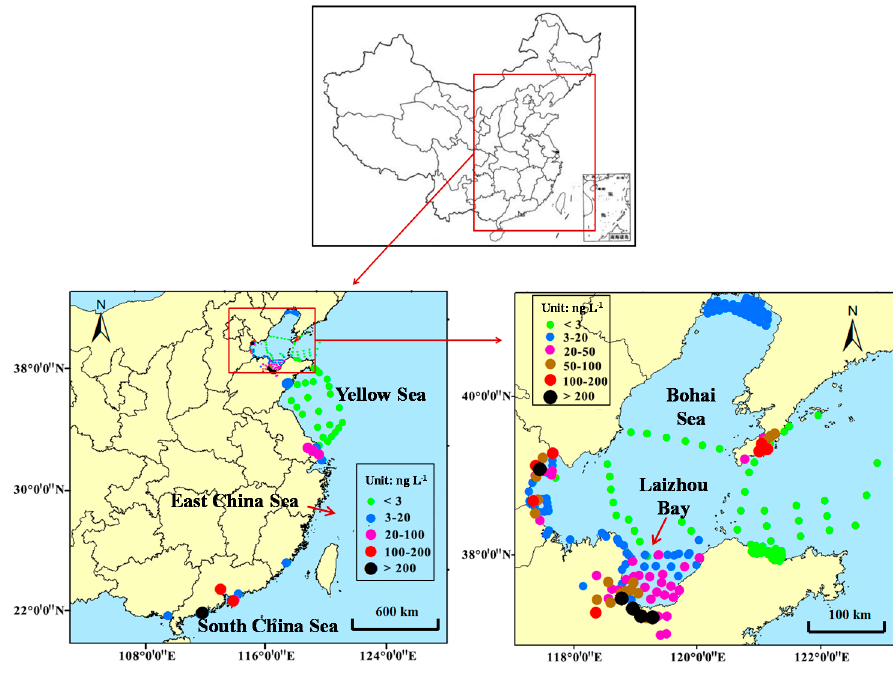
Figure 1. Levels of antibiotics in coastal water around China [9–22]. Table 1. Level range and mean level of antibiotics in coastal water around China (unit: ng L -1 ) [9–22]. Antibiotic